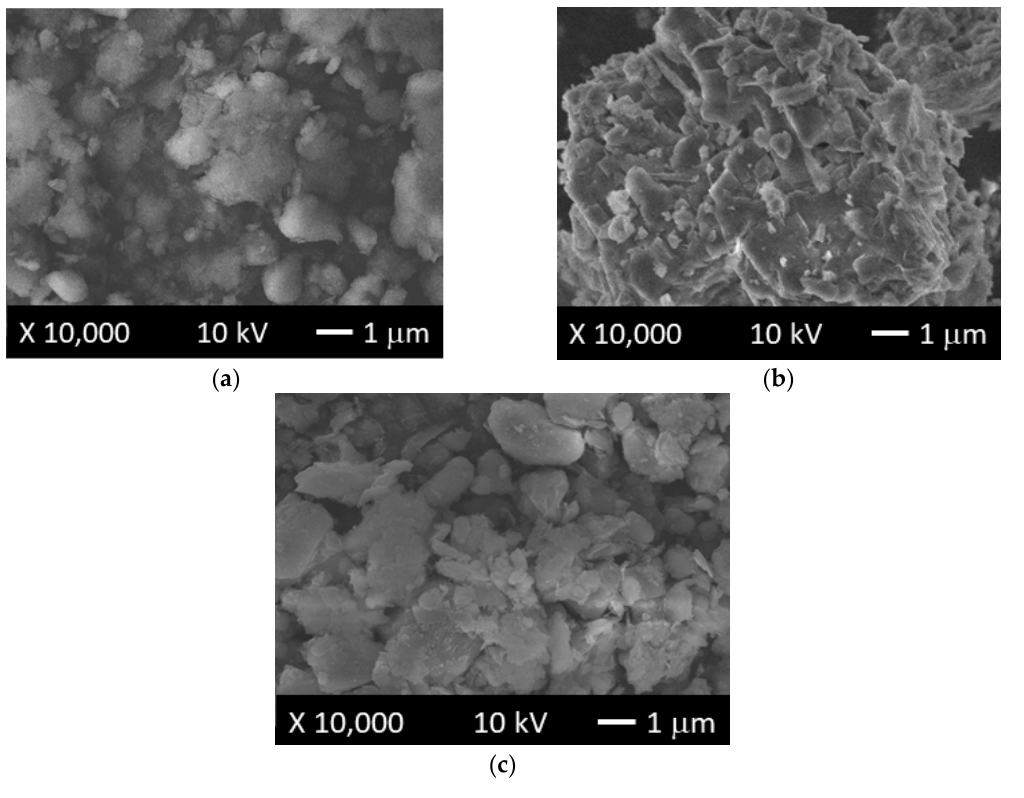
Figure 8. SEM micrographs of ( a ) raw clay mineral (sepiolite), and ( b ) OMH- and ( c ) OMP-modified clays.